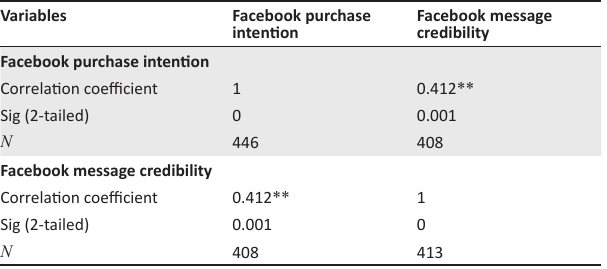
TABLE 1: Correlations for Facebook message credibility and intention to purchase. Variables